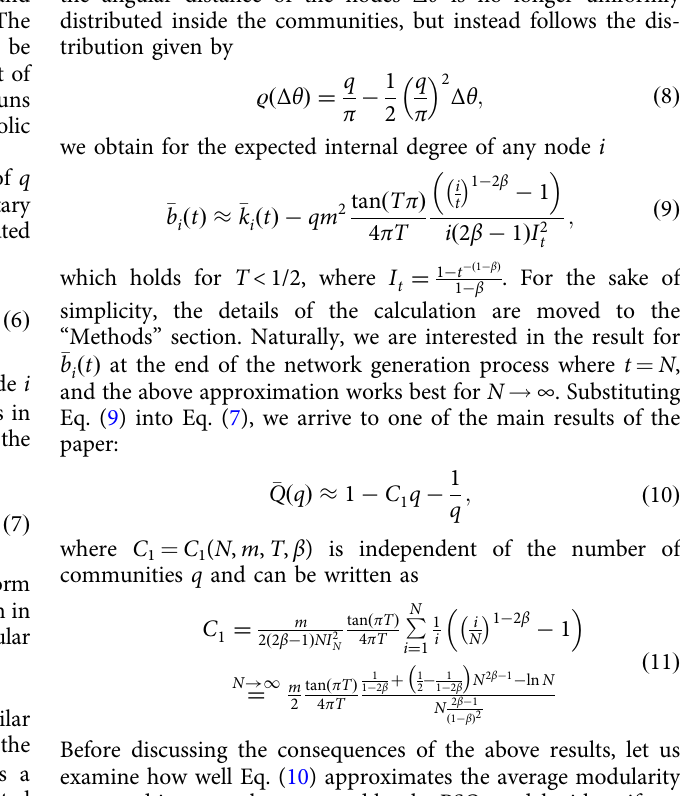
Fig. 1 Visualisation of two different uniform partitioning schemes of the same PSO network with an average degree generated at β = 0.6, T = 0.1. In both panels, the red dashed lines indicate the boundaries of the modules obtained by dividing the entire hyperbolic disk into equally sized angular sectors. In panel a we used q = 4 and α = 0, whereas panel b depicts a partitioning where the parameters were set to q = 6 and α =